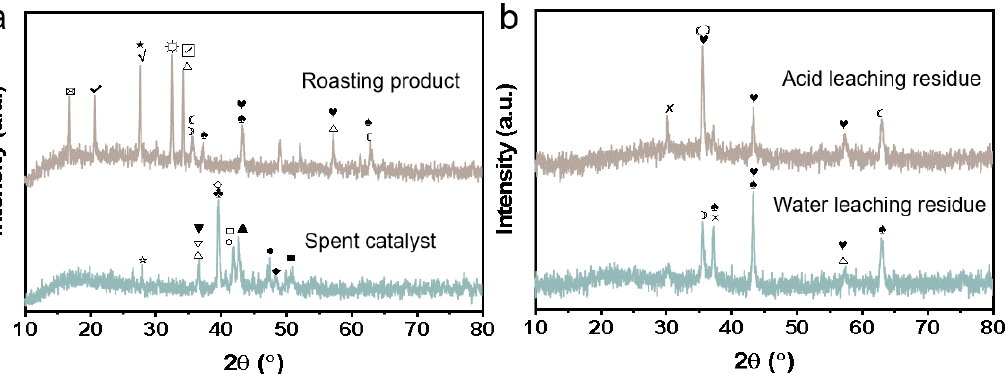
Figure 2. XRD patterns of waste HDS catalyst powder and oxidized roasting product of sodium salt ( a ), deionized water leaching residue and sulfuric acid leaching residue ( b ). CoO ( △ ), FeAl 2 O 4 ( ▽ ), FeO ( ○ ), Mo 2 Ni 6 P 3 ( ◇ ), Ni 3 P ( □ ), VO 2 ( ☆ ), V 14 O 6 ( ♣ ), Mo 5 Si 3 ( ▲ ), Ni 2 SiO 4 ( ▼ ), Ni 2 P ( ● ), CoP ( ◆ ), MoNi 4 ( ■ ), AlPO 4 ( ★ ), NiO ( ♠ ), Al 2 O 3 ( ), Fe 2 O 3 ( ☽ ), Na 3 PO 4 ( ☑ ), NaVO 3 ( √ ), NaMo 2 (PO 4 ) 3 ( ✔ ), Na 3 Mo(P 2 O 7 ) ( ☒ ), Na 5 P 3 O 10 ( ☼ ), NiFe 2 O 4 ( ☾ ), Co 2 P (×), NiSiO 3 ( ✘ ) are the symbolized peaks in the XRD graphs.